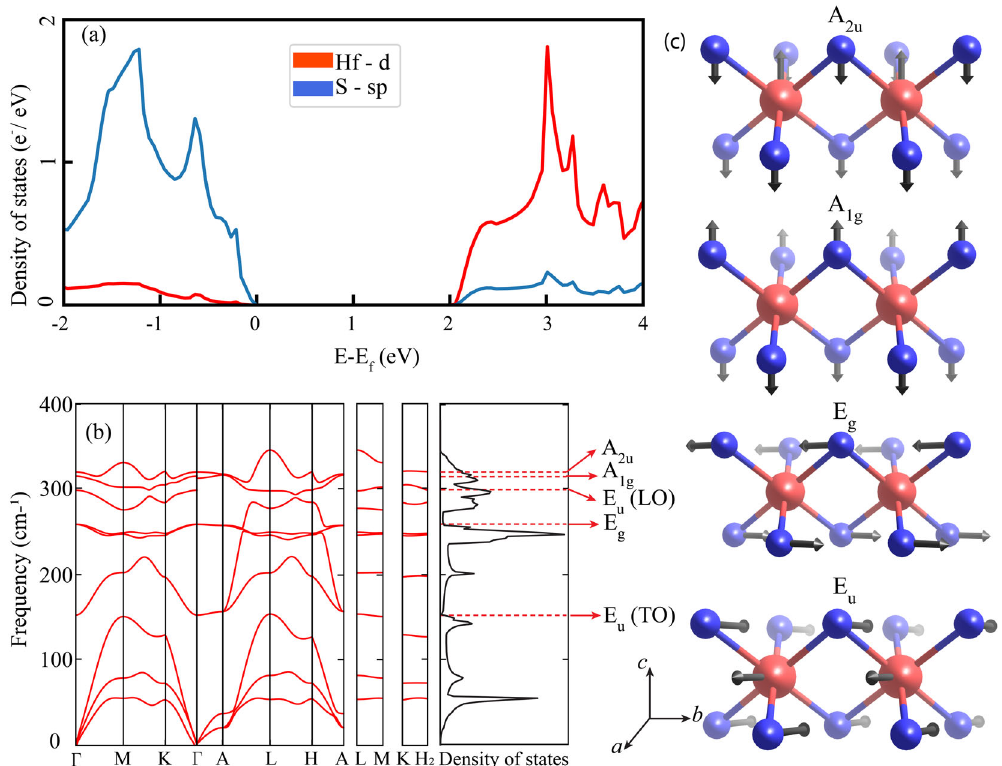
Fig. 1 Density of states and displacement patterns of 1T-HfS 2 . a The electronic density of states of 1T-HfS 2 . Different colors indicate different orbitals of the two types of atoms. b The phonon spectrum of 1T-HfS 2 and its density of states. The Γ -point phonon mode frequencies are marked with dashed lines. c Displacement patterns of several Γ -point phonon modes. Blue atoms are S and the red atoms are Hf. The arrows are not scaled to real displacement amplitudes. Numerical details are available in Supplementary Information.